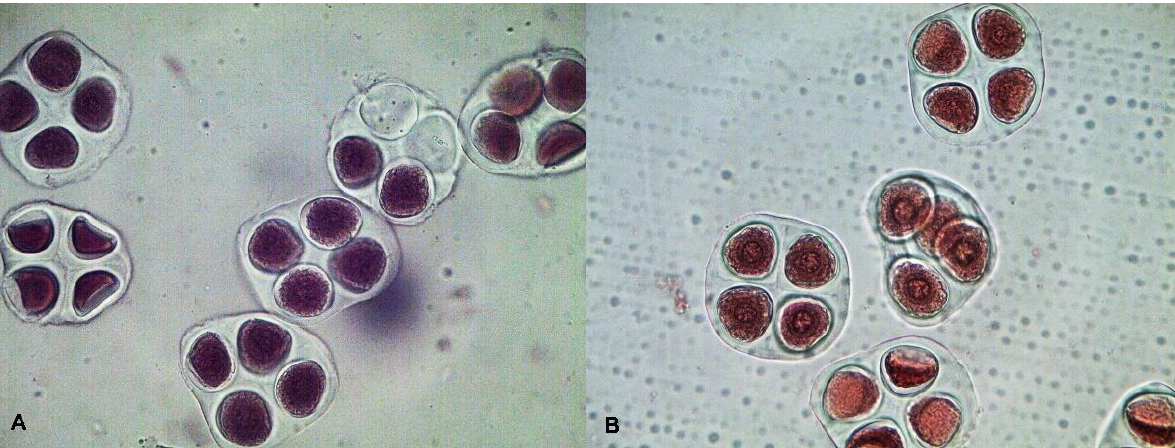
Figure 6. Meiotic index: ( A ) photoperiod-sensitive wild-type G. hirsutum subsp. purpurascens (var. El-Salvador) — 94.15 ± 0.64%; ( B ) day-neutral mutant line (var. Kupaysin) — 94.60 ± 0.59%.